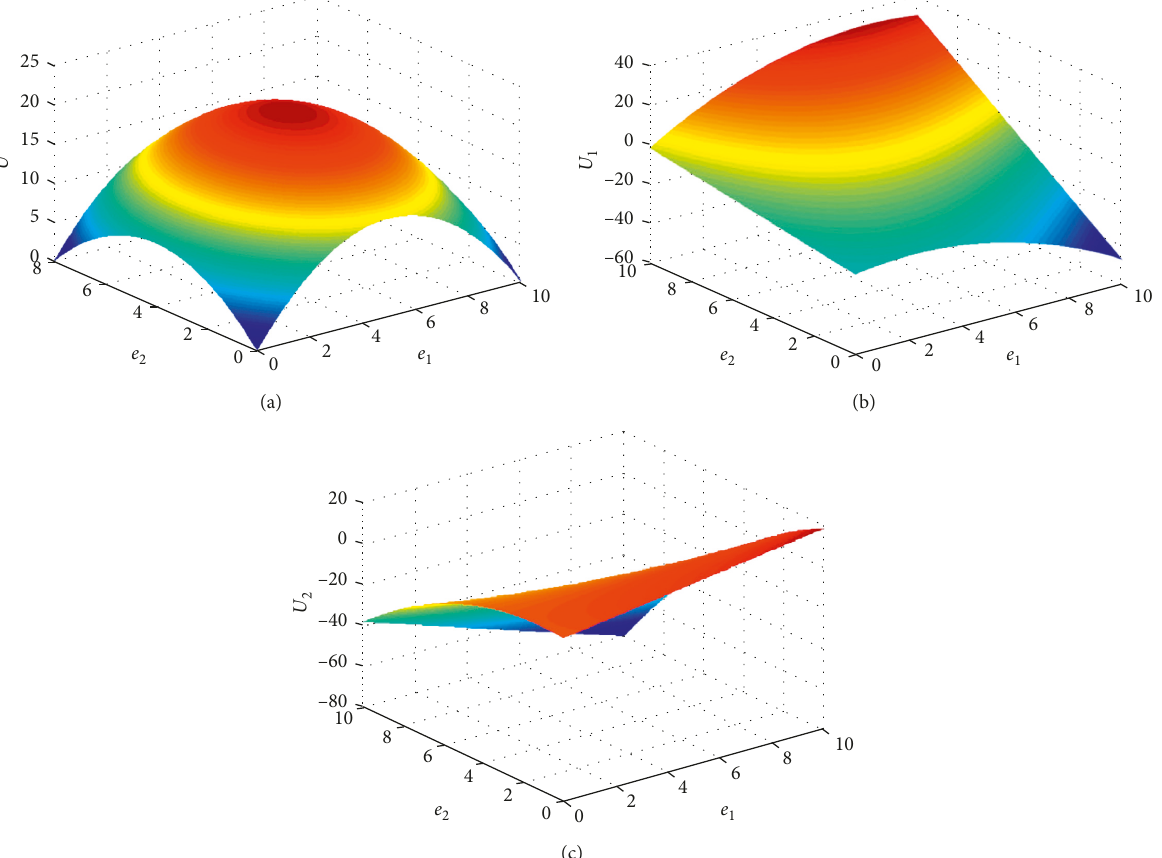
Figure 2: Effects of effort levels of the owner and contractor on project benefits. (a) Effects of e (c) Effects of e 1 and e 2 on U 2 .